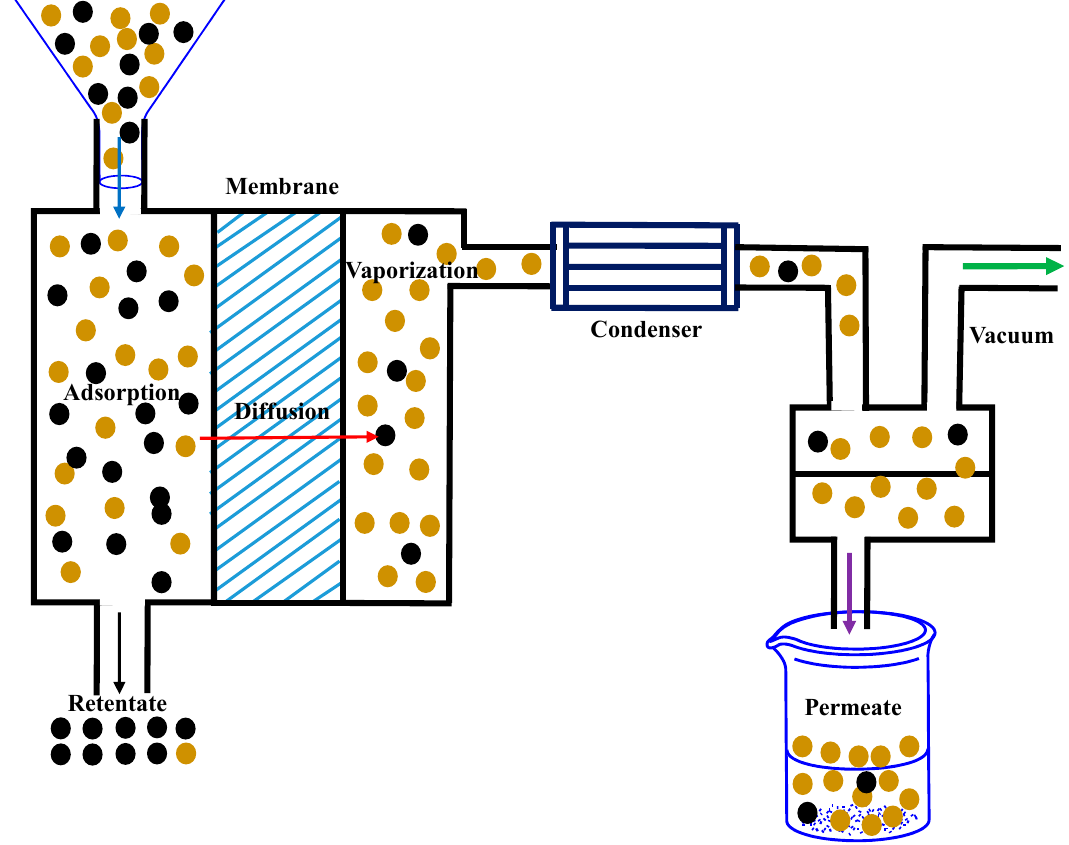
Figure 8. Schematic of basic gasoline desulphurization by PV.